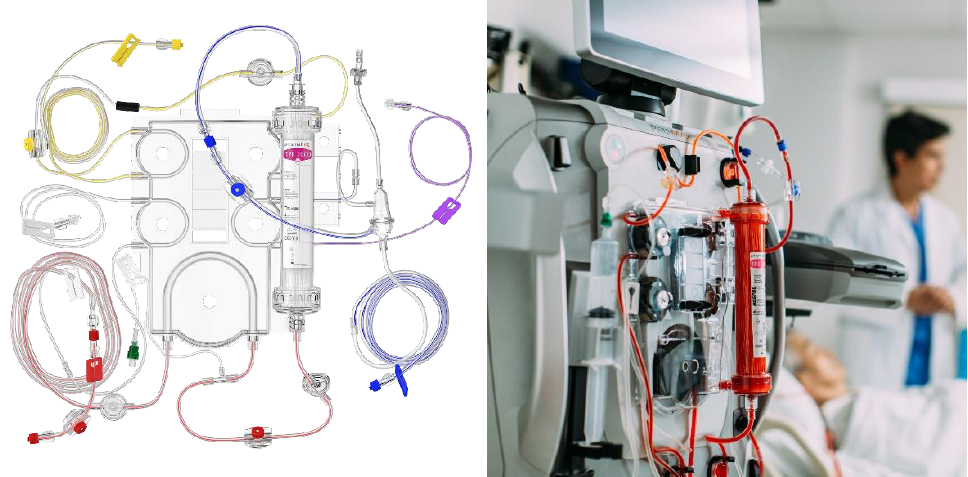
Figure 1. Semipermeable membrane-based plasmapheresis with heparin anticoagulation (Baxter ® educational materials): yellow—effluent line, transparent—heparin line, red—arterial line, blue—venous line, purple—replacement fluid line.